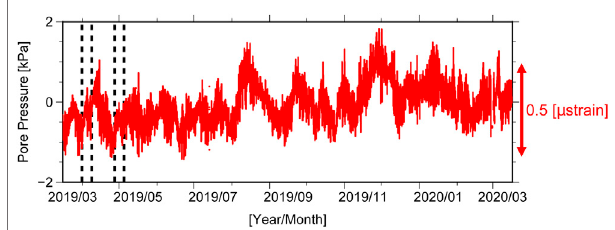
FIGURE7| Timehistoryoftheporepressureatthedeepeststations(Pc1)of C0010 with a volumetric scale for each station (vertical double arrows) from one year before to the one day before the onset time of the pore pressure event. Two pairs of vertical dotted lines indicate the time windows of best fi tting regressionlinesforCase(A-1)to(A-2+)asindicatedbyverticalarrowsin Figure8 .